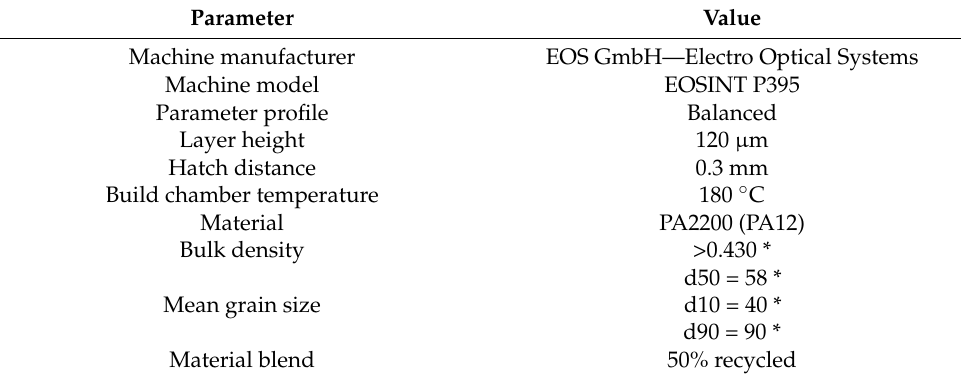
Table 4. Build process